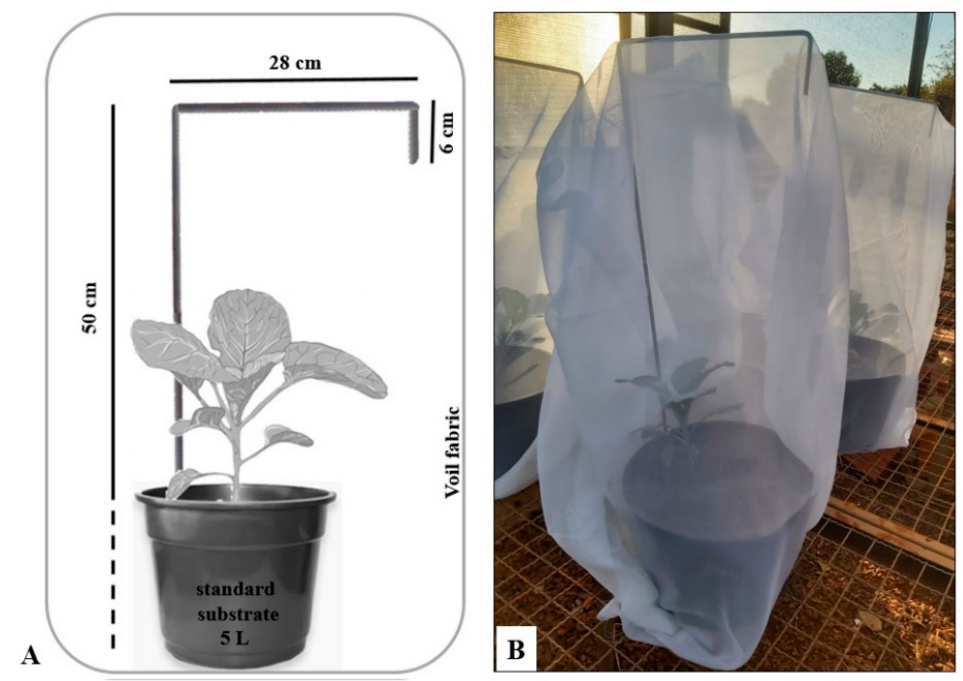
Figure 1. ( A ). Sketch of the experimental unit of the bioassay. ( B ). Execution of the bioassay in a semi-field